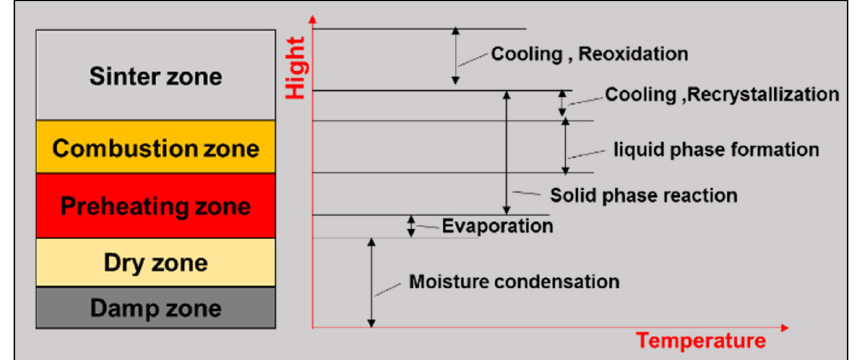
Figure 2. Various zones in the sintering bed in the height direction.